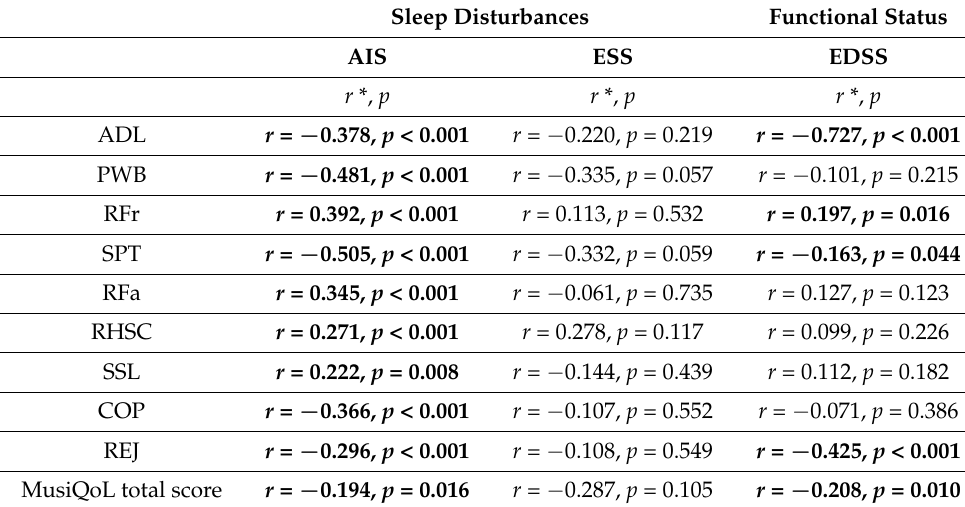
Table 3. Spearman’s rank correlations between each studied variable. Sleep Disturbances Functional Status AIS ESS